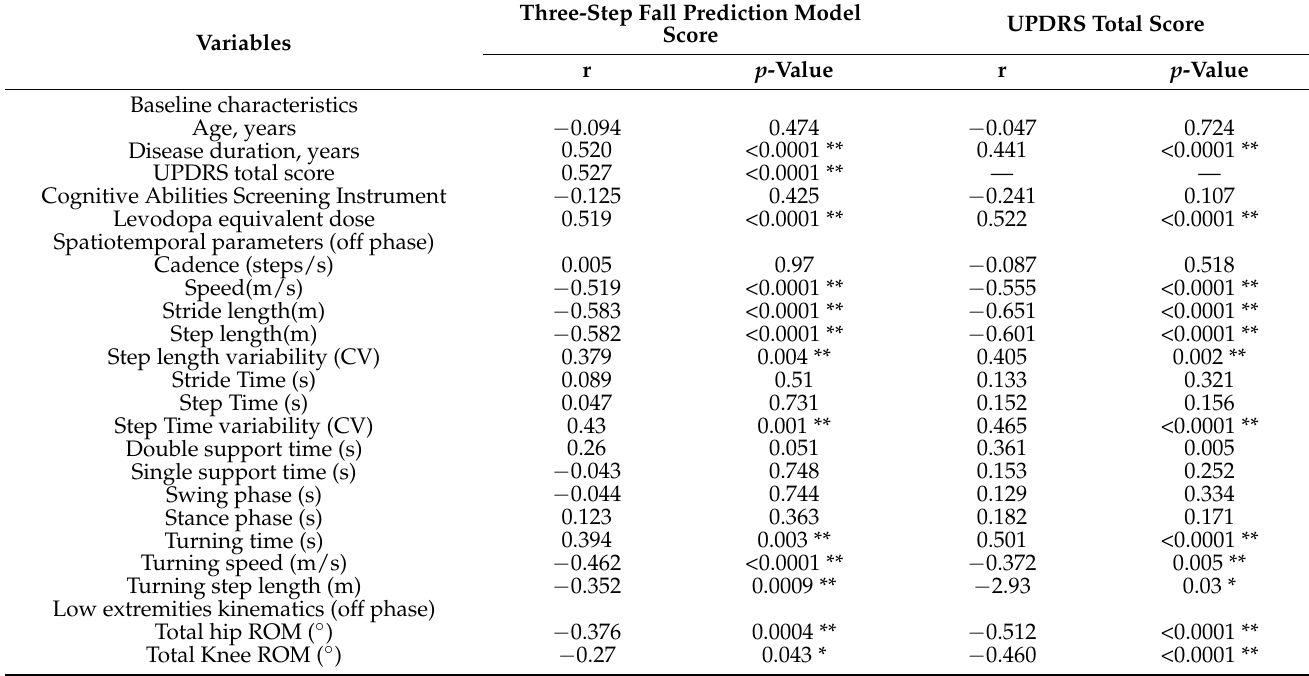
Table 5. Correlation analysis between the three-step fall prediction model score and UPDRS total score, and parameters of spatiotemporal and kinematic